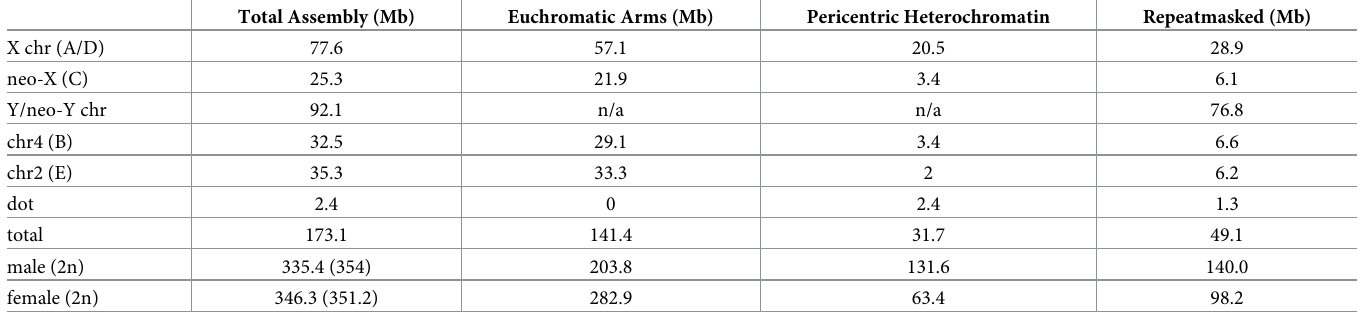
Table 1. Assembled length for each chromosome, size of chromosome arms and pericentromere, and repeat-masked bases (in Mb). The total genome size inferred from flow cytometry is given in